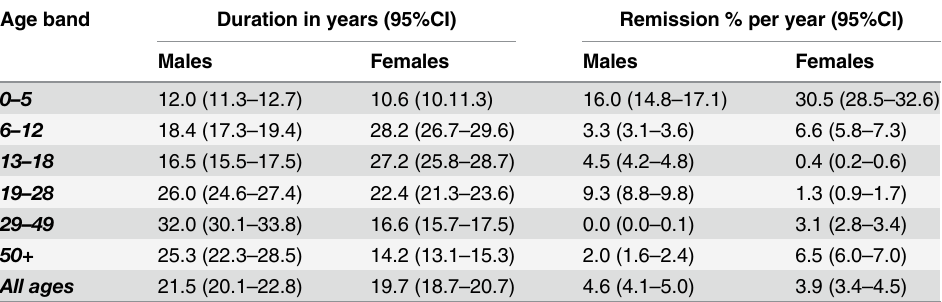
Table 3. Duration and remission convulsive epilepsy using DISMOD II, Agincourt 2012. Age band